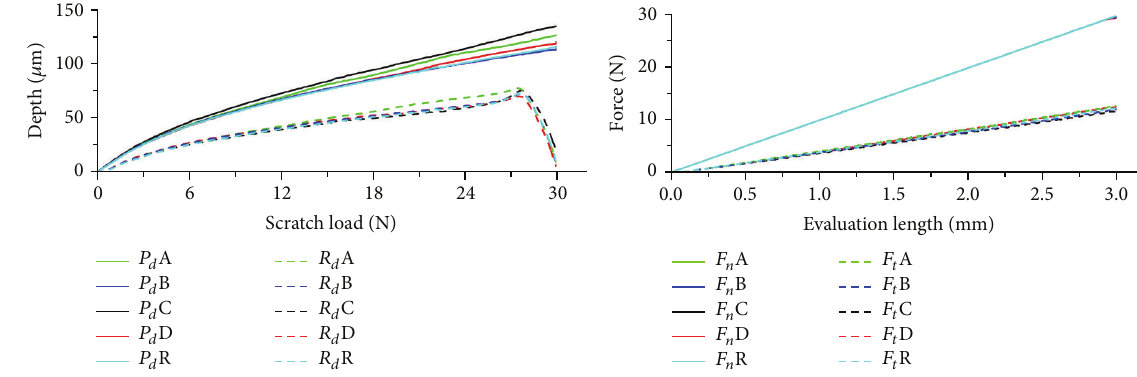
Figure 6: Results of progressive scratch tests: comparison between coatings A–D and reference (R).